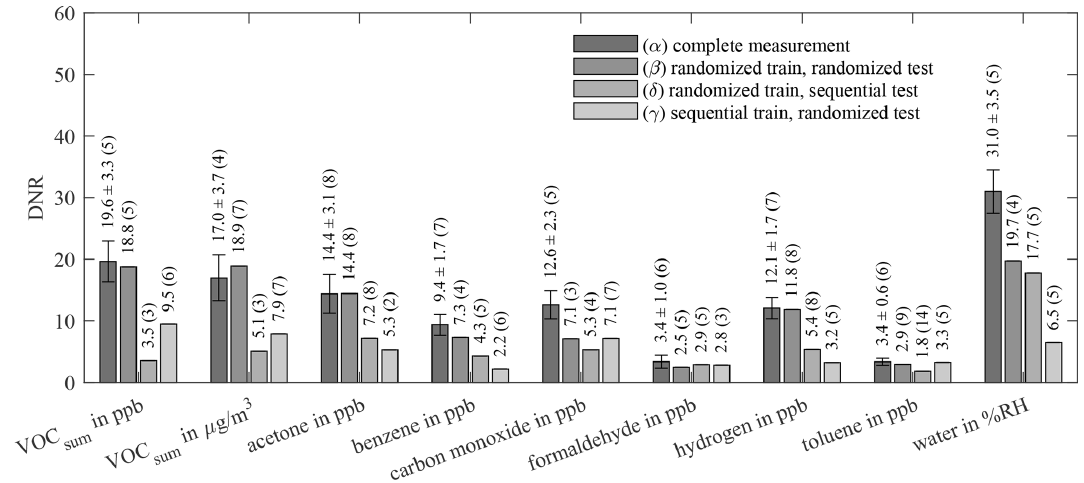
Figure C2. Dynamic range (DNR) of AS-MLV for different training and testing models and targets. All models use 10-fold cross-validation for hyperparameter optimization; the resulting number of PLSR components, determined with Eq. (2), is given in parentheses. A detailed description of ( α )–( δ ) is given in Table